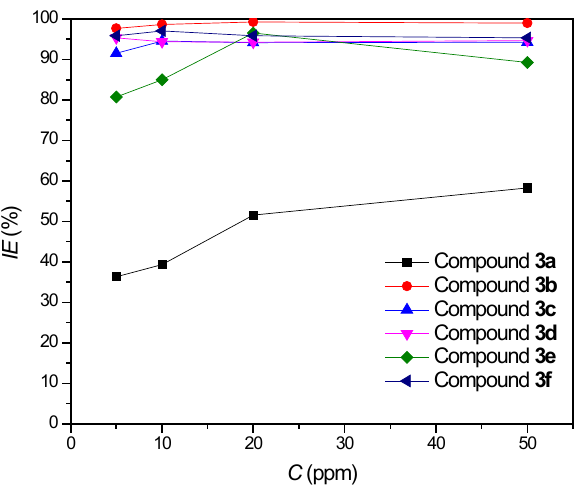
Figure 5. Variation of inhibition efficiency by xanthine triazole for API 5L X70 immersed in HCl 1 M.